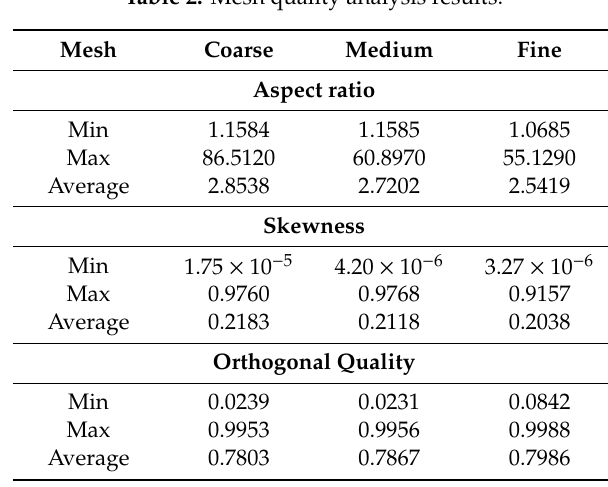
Table 2. Mesh quality analysis